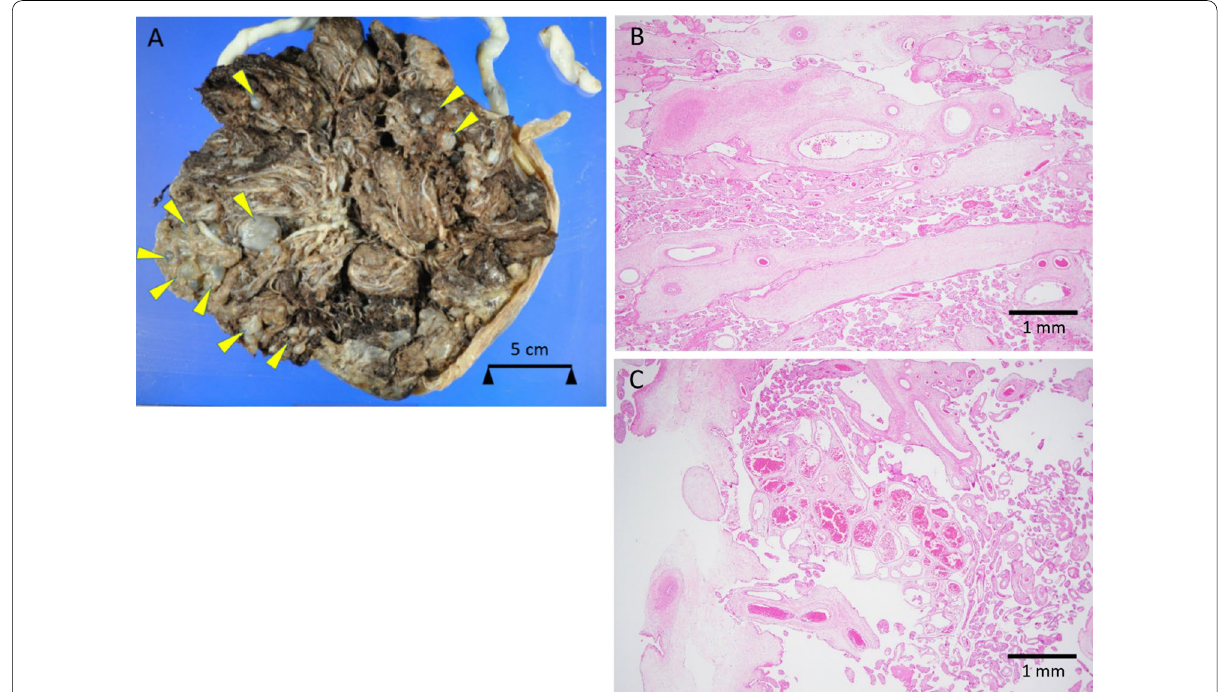
Fig. 1 A Maternal surface of placenta shows multiple cysts of various size (arrowheads). B Microscopically, the placenta shows enlarged stem